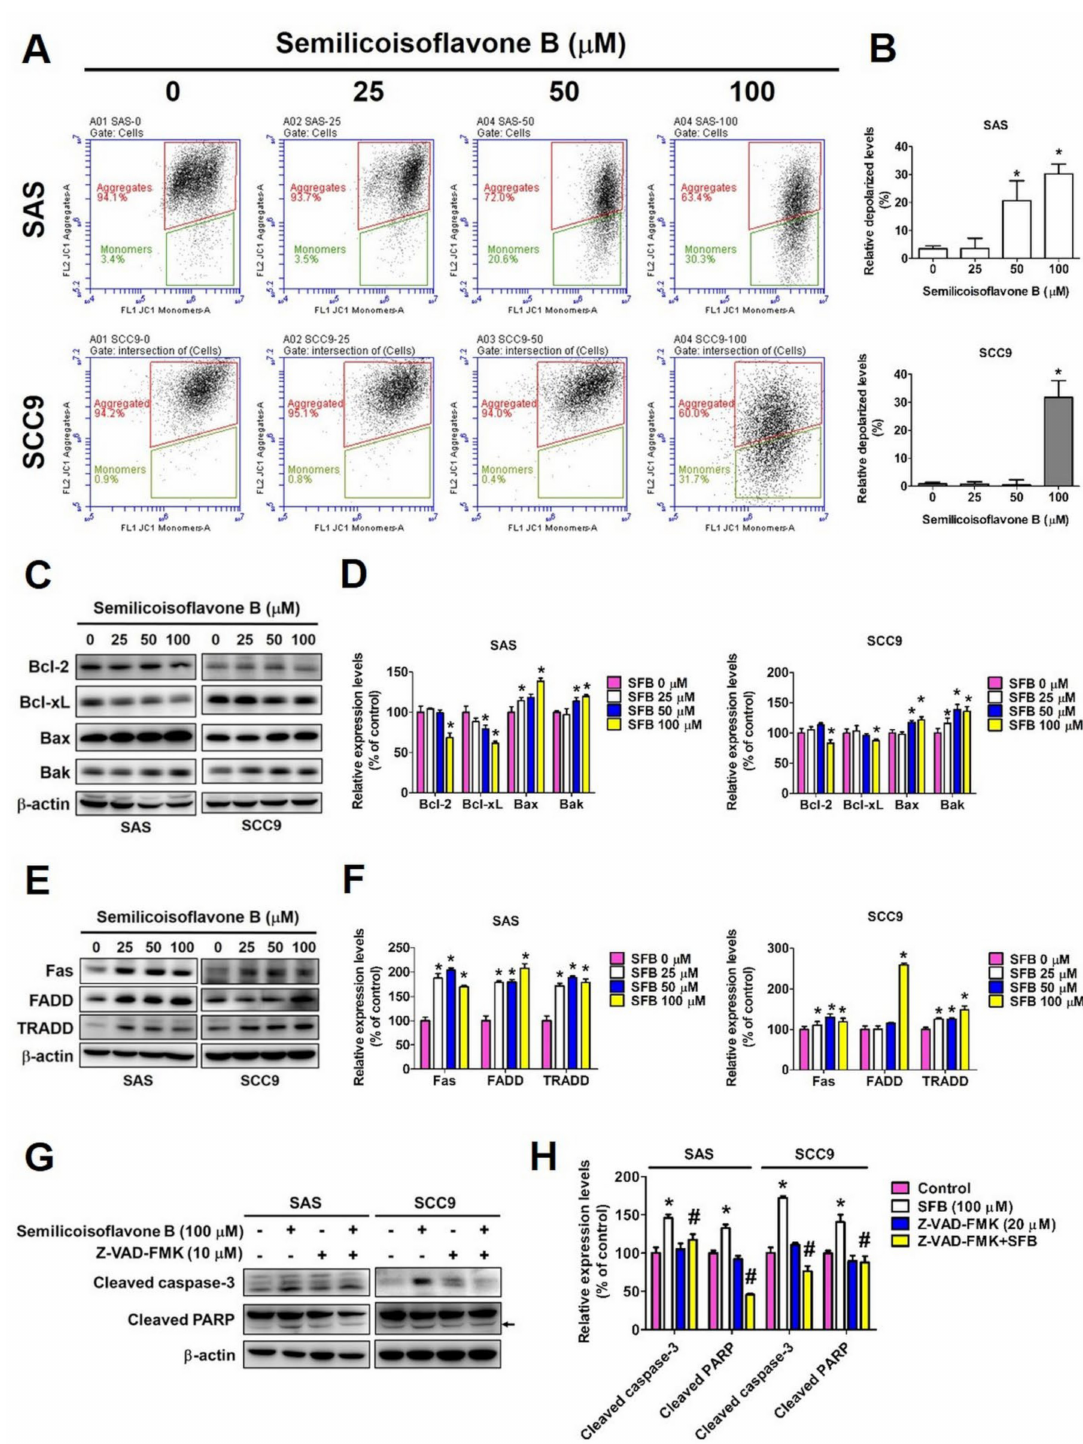
Figure 4. Intrinsic pathway and the extrinsic pathway were regulated by semilicoisoflavone B in oral cancer cell lines. After treated SFB (0–100 µ M) for 24 h. ( A ) Mitochondrial membrane potential measurement assay was used by flow cytometry. ( B ) The data was analyzed by BD CSampler Plus software. ( C ) Analyze the expression of Bcl-2 family proteins, including Bcl-2, Bcl-xL, Bax and Bak by Western blotting. ( D ) Quantitative relative density of each protein level was normalized to β -actin. ( E ) Analyze the expression of intrinsic pathway control proteins, including Fas, FADD, and TRADD by Western blotting. ( F ) Quantitative relative density of each protein level was normalized to β